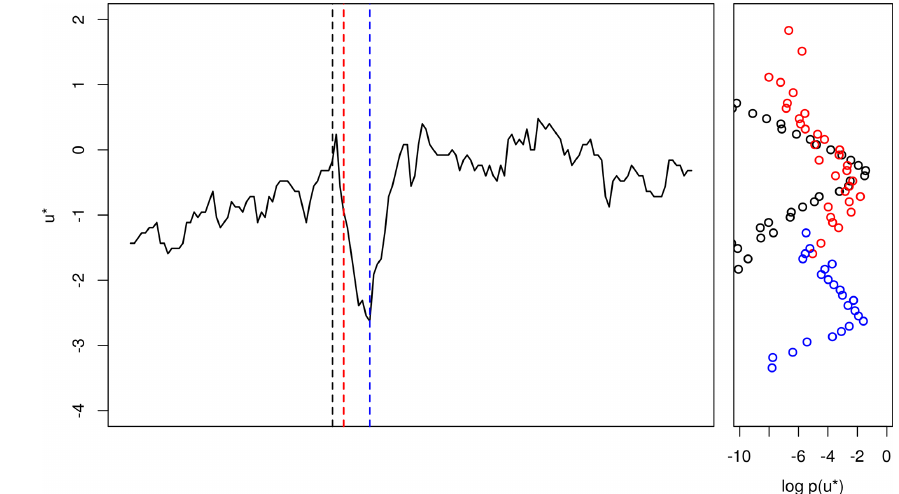
Figure 8. Evolution of p ( u ∗ | u 1 ,...,u N ) during reconstruction. Horizontal lines indicate snapshots of the pdf used for drawing the next sample of u ∗ . The colours of the horizontal lines correspond to the snapshot